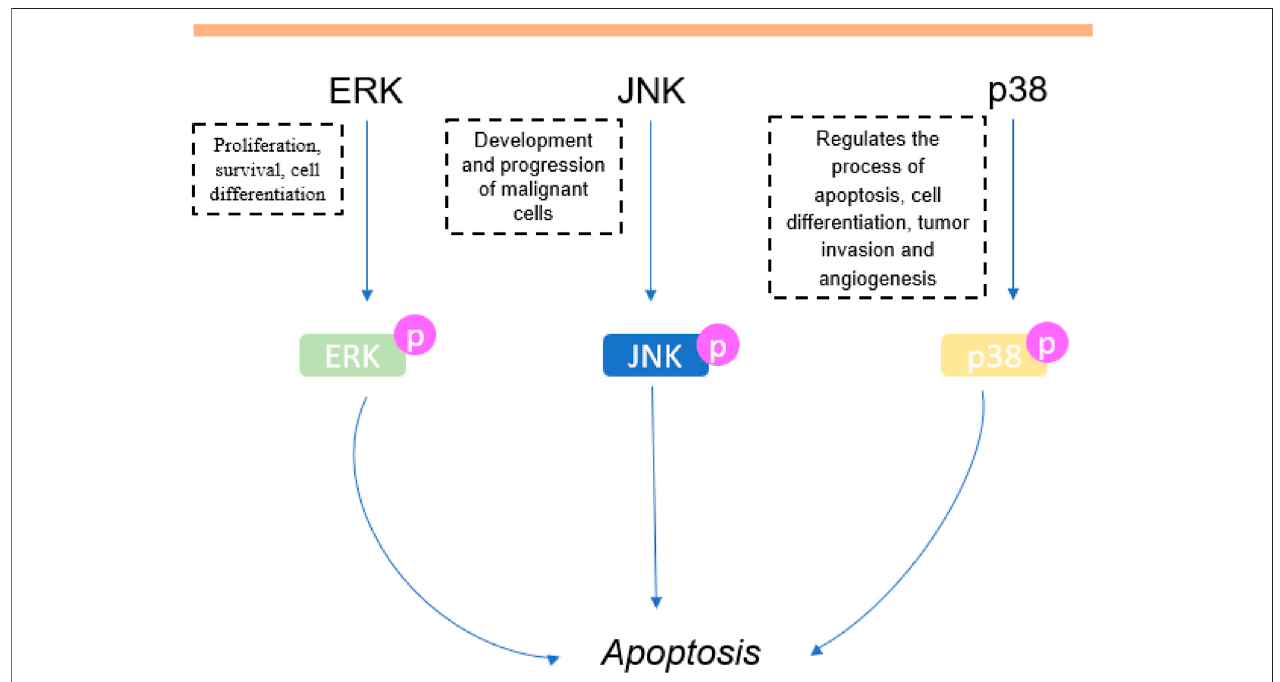
FIGURE 7 | Involvement of the MAPK pathway in carvacrol and thymol treatment in cancer.